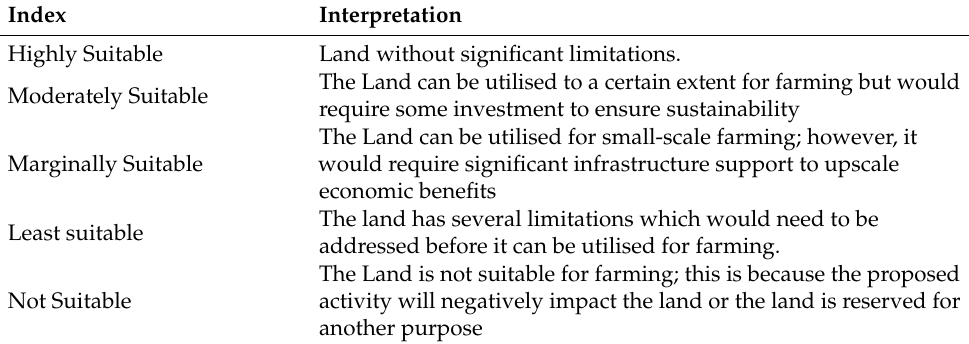
Table 4. Mapping and criteria rule sets.